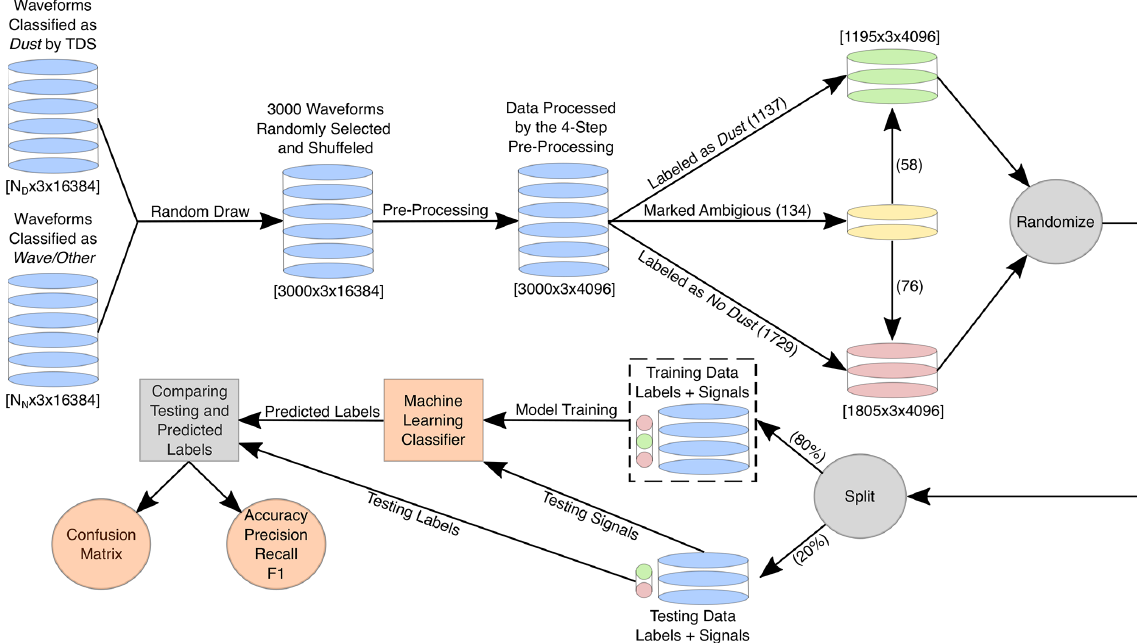
Figure 3. Data flow, from the TDS data sets to the machine learning performance metrics. The diagram illustrates the data flow by the black arrows and the applied process by the arrow label. The cylinders indicate the signal waveforms and the cylinder color indicates the associated label. The gray circles mark data transformation processes. The random draw of the TDS data and the pre-processing is explained in Sect. 3.1, while the manual labeling is described in Sect. 3.2. A description of the randomization and splitting of the manually labeled data into a training and a testing set is included in Sect. 3.3. Sections 3.4 and 3.5 explain the training and testing of the machine learning classifiers. Finally, the performances of the machine learning classifiers are compared and evaluated in Sect.